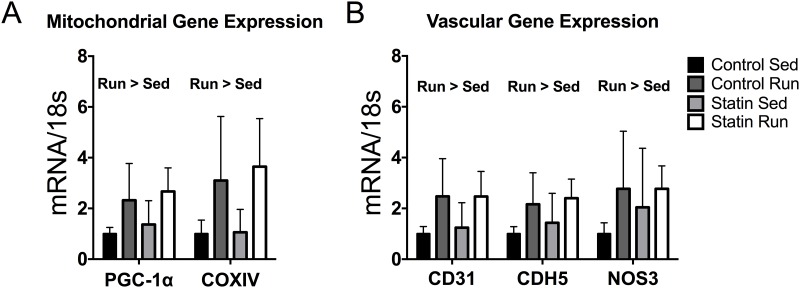
The effects of exercise training and simvastatin treatment on mitochondrial and vascular gene expressions (n = 7–8 per exercise/treatment group).A: Fold change relative to control sedentary mice in expression of genes involved in mitochondrial biogenesis. Run > Sed indicates main effect of training, all P < 0.002. B: Fold change relative to control sedentary mice in expression of genes involved in vascular signaling. Run > Sed indicates main effect of training, all P ≤ 0.046.